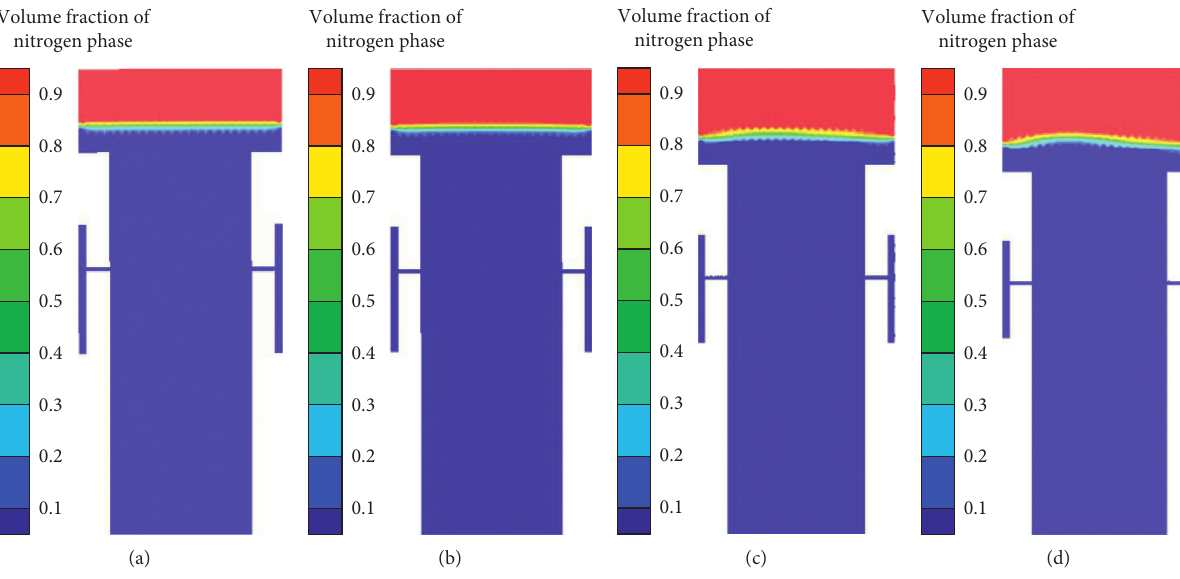
Figure 9: Volume changes of oil and nitrogen during the extension stroke at (a) t � 0.02s, (b) t � 0.04 s, (c) t � 0.08s, and (d) t � 0.1 s. The blue area is the hydraulic oil, the red area is the nitrogen, and the green area is the interface between the two